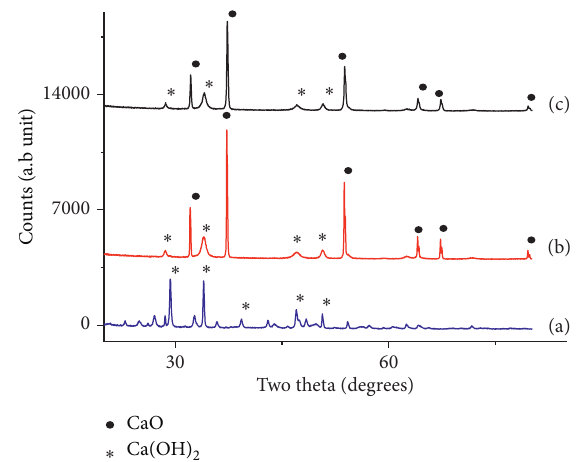
Figure 4: XRD pattern of samples: (a) Ca(OH)